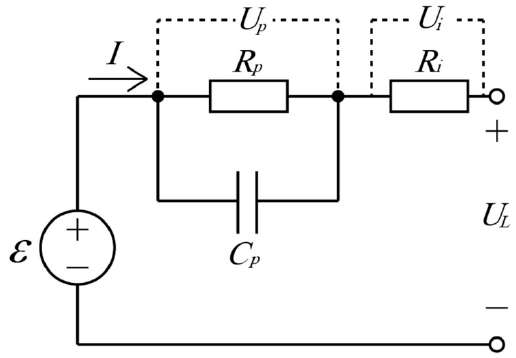
Figure 1. A battery equivalent circuit model (ECM).